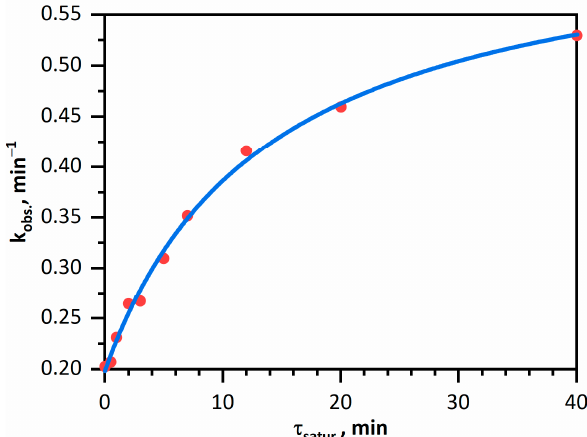
Figure 5. Observed relative rate constant of Fe(CN) 63 − reduction with hydrogen vs. time of palladium saturation with hydrogen. The dots correspond to the experiment and the curve shows calculations.